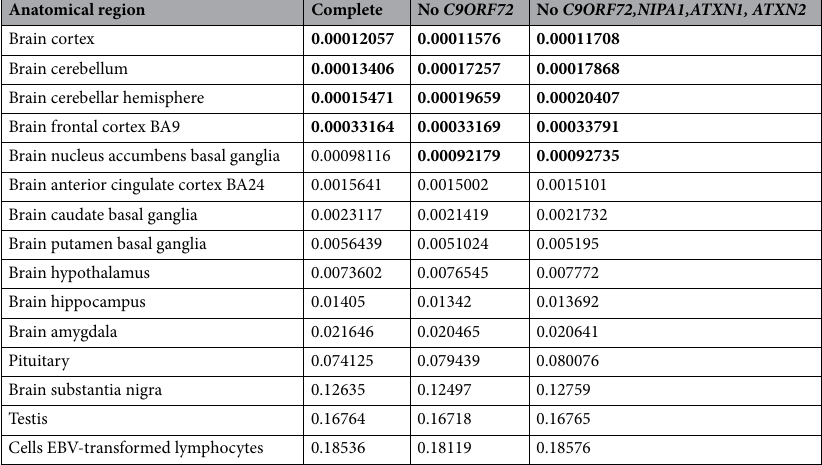
Anatomical region Complete No C9ORF72 No C9ORF72,NIPA1,ATXN1, ATXN2 Brain cortex 0.00012057 0.00011576 0.00013406